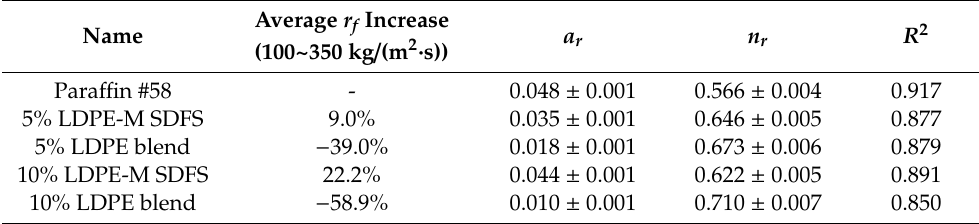
Table 12. Fitting results of r f vs. G ox for LDPE / Para ffi n fuels comparing 5% and 10% LDPE addition by blend and by SDFS composites (M = medium particle size) [28,32]. Copyright Wiley (2017) and Begell House (2018). Reproduced with